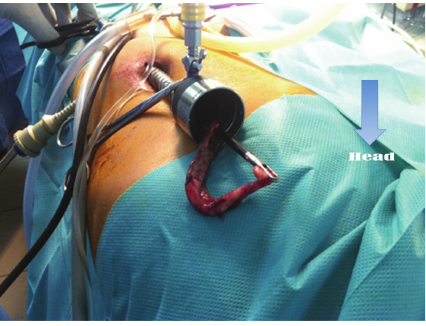
Figure 4: Extraction of the appendix through the umbilical trocar.